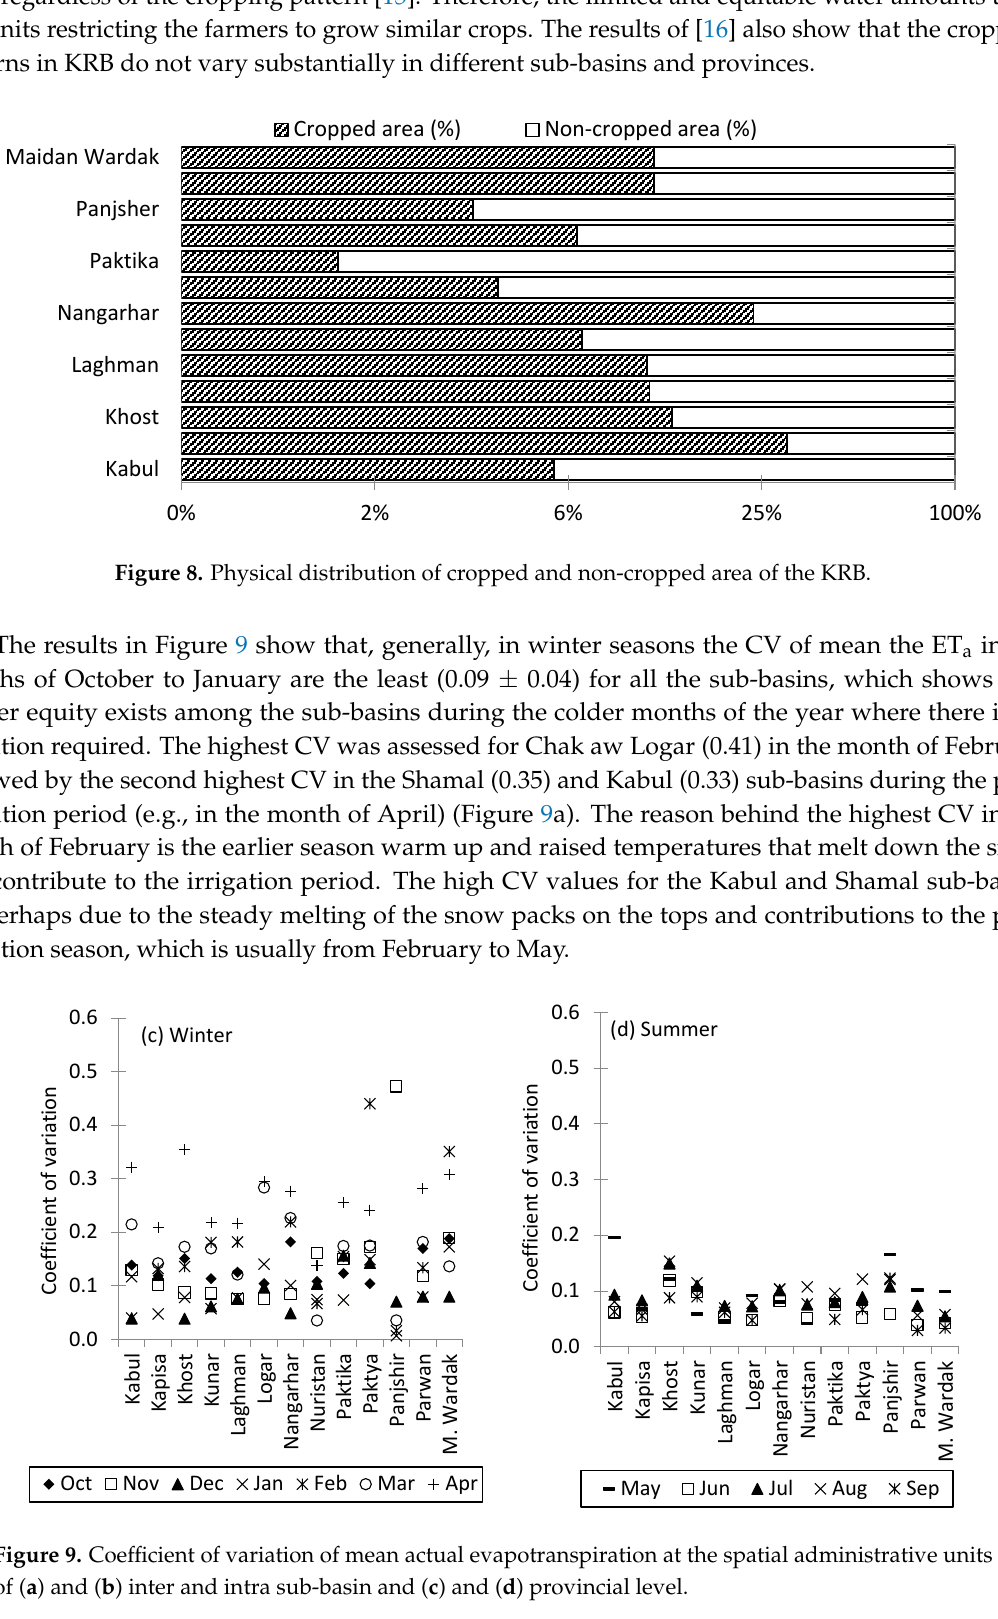
( b ) Figure 10. Seasonal relative evapotranspiration in ( a ) Winter and ( b ) Summer across the Kabul River Basin. For winter season, the highest RET for Ghorband aw Panjshir and Chak aw Logar sub-basins was 0.50 and 0.48, respectively, while the lowest RET was in the Gomal sub-basin (i.e., 0.28) (Figure